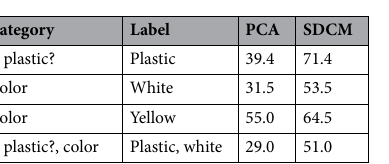
Figure 4. ( a ) PCA, ( b ) SDCM. The histograms show the distribution of f 1 scores of each match for PCA and SDCM. A large f 1 score corresponds to a close match between cluster and EC.